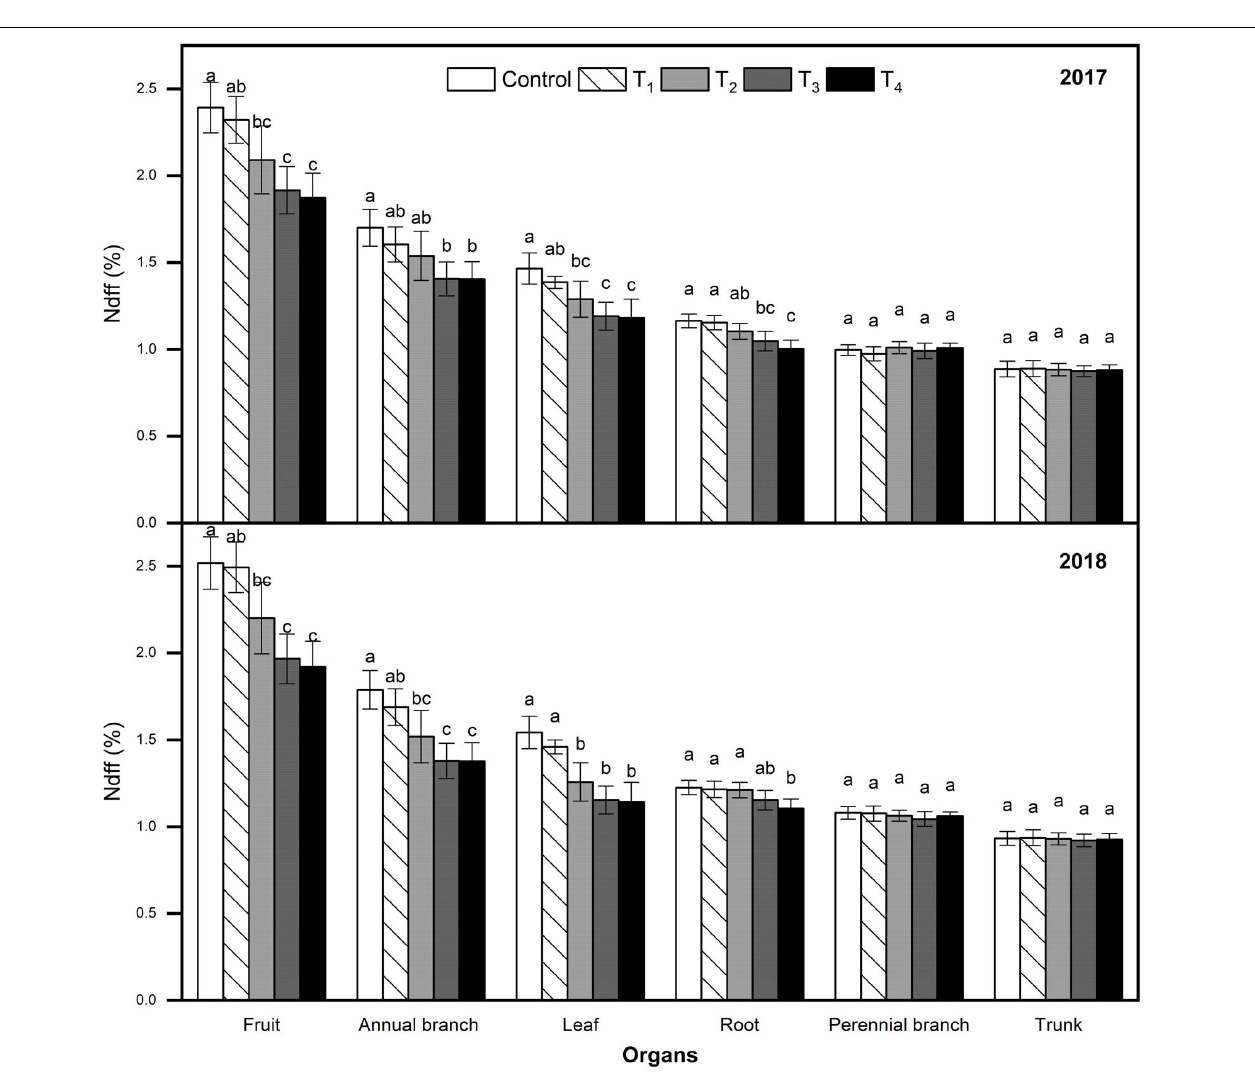
FIGURE 6 | Effects of DMPP on Ndff value at the fruit maturity stage in 2017 and 2018. The vertical bar indicates the standard deviation of three replications. Different letters indicate statistically significant differences ( P < 0.05).